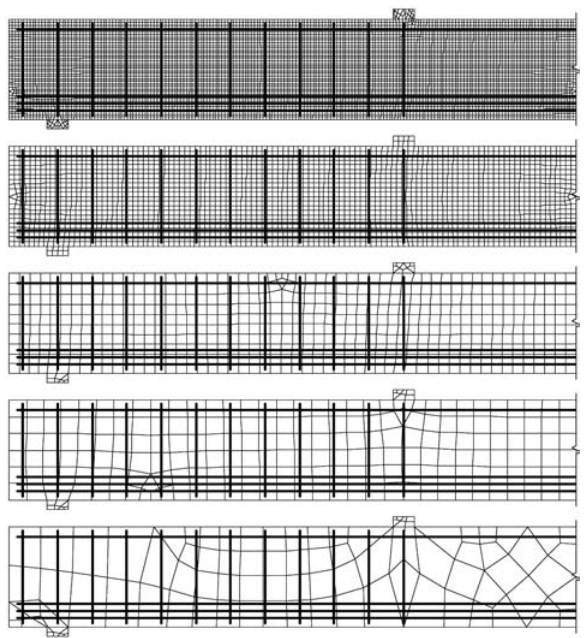
Fig. 2. Scaled constitutive relationships (Gribniak et al. 2007)